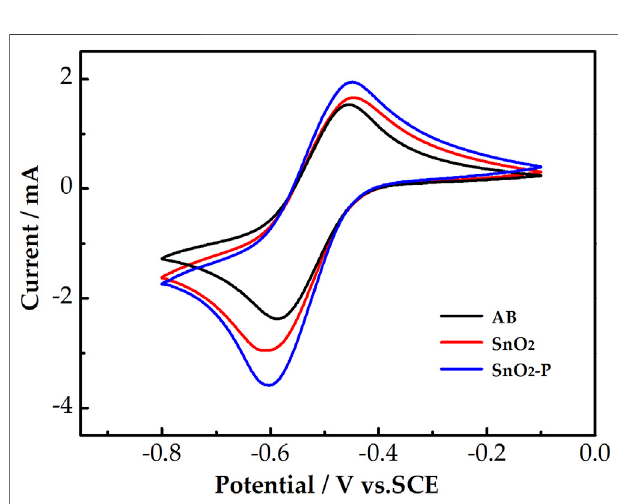
symmetrical with an increasing scan rate. This proves that the electrochemical stability is good. In addition, the peak current increases as the scan rate increases. The oxidation and reduction peak potentials shift to the right and left, respectively. Figure 5D shows the relationship between the square root of the scan rate and the redox peak current. The peak current is obviously proportional to the square root of the scan rate for all samples.